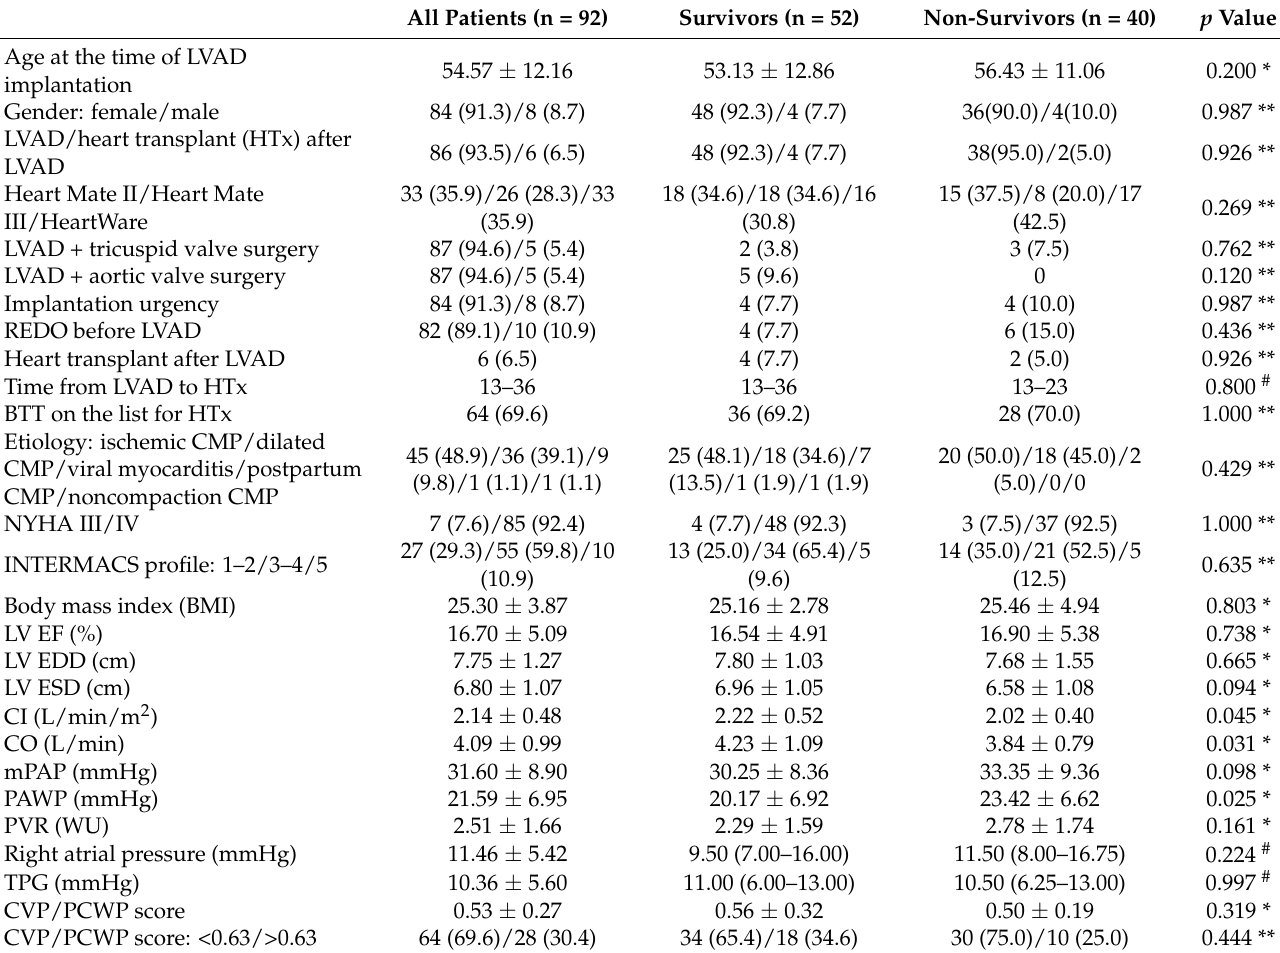
Table 1. Patient socio-demographic and clinical features—baseline